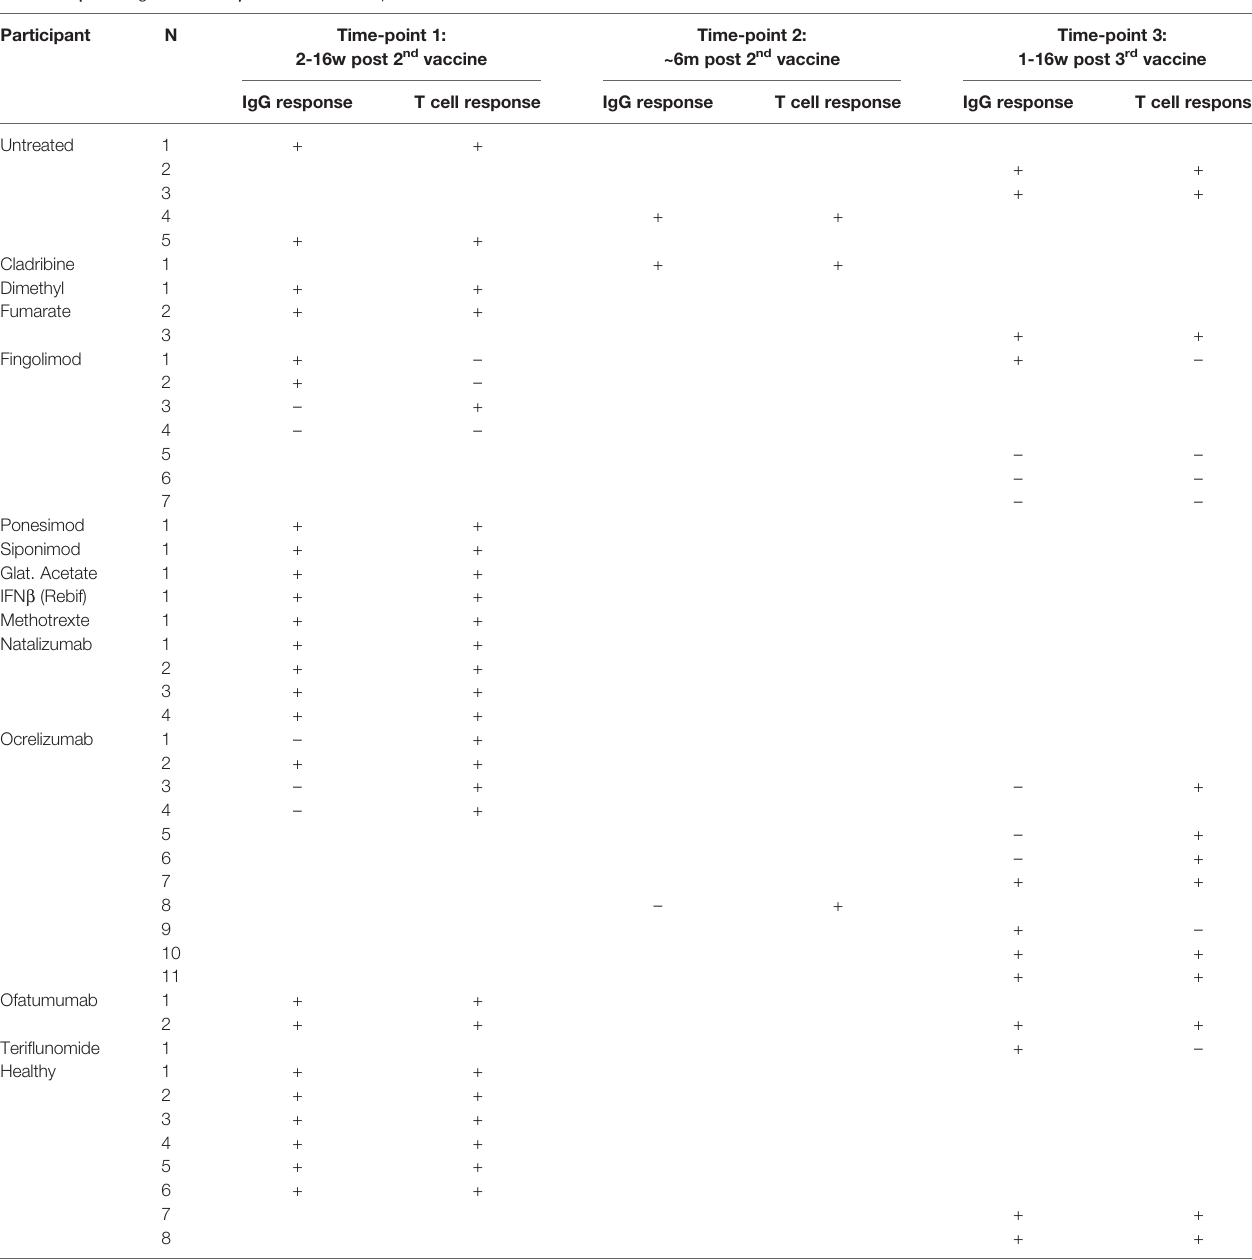
TABLE 3 | Serological and IFN g -T cell immune